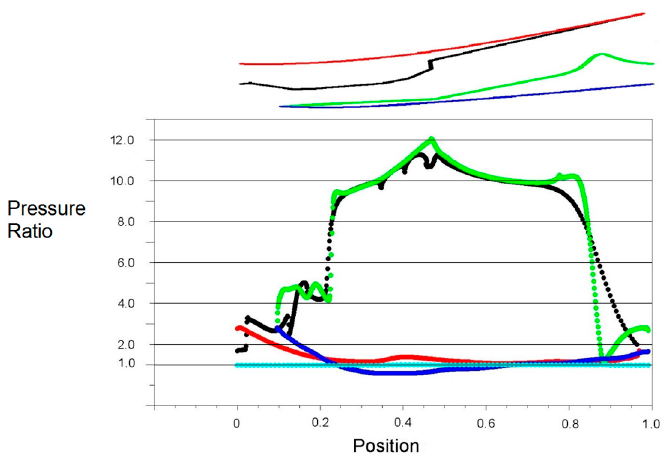
Figure 26. Pressure distribution on the walls of the engine channels.